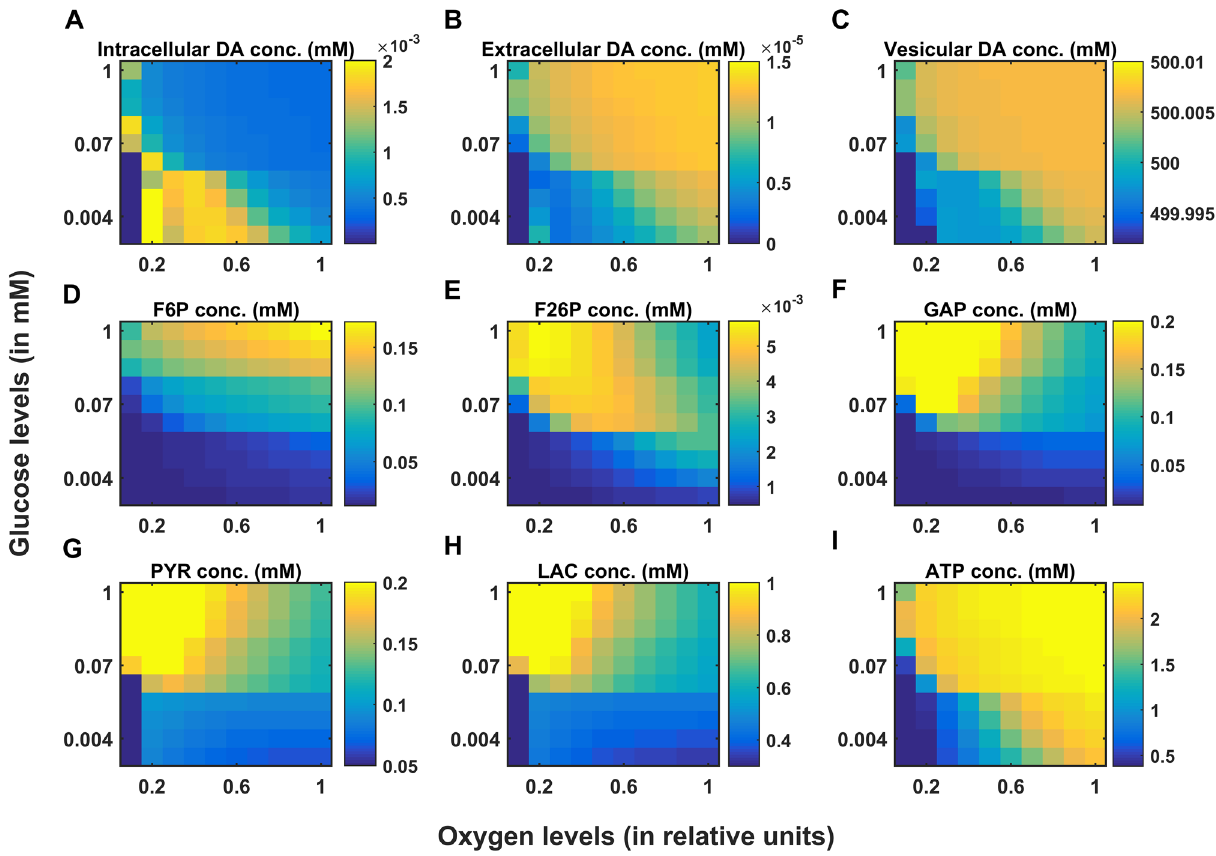
Figure 6. Model response to hypoglycemia and hypoxia conditions. Average intracellular dopamine (DA) concentration ( A ), average extracellular DA concentration ( B ), average vesicular DA concentration ( C ), average fructose-6-phosphate (F6P) concentration ( D ), average fructose-2,6-biphosphate (F26P) concentration (E), average glyceraldehyde-3-phosphate (GAP) concentration ( F ), average pyruvate (PYR) concentration ( G ), average lactate (LAC) concentration ( H ), average adenosine triphosphate (ATP) concentration ( I ) of the model for varying glucose and oxygen concentrations. conc, concentration; mM, millimolar.